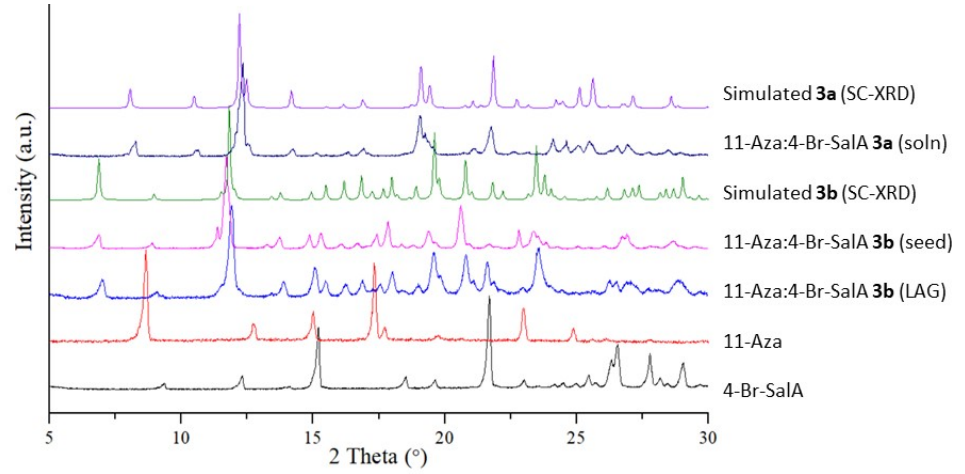
Figure 3. Powder X-ray diffractograms for 3a (from solution growth ) and 3b from LAG along with the coformers 11-Aza and 4-Br-SalA.